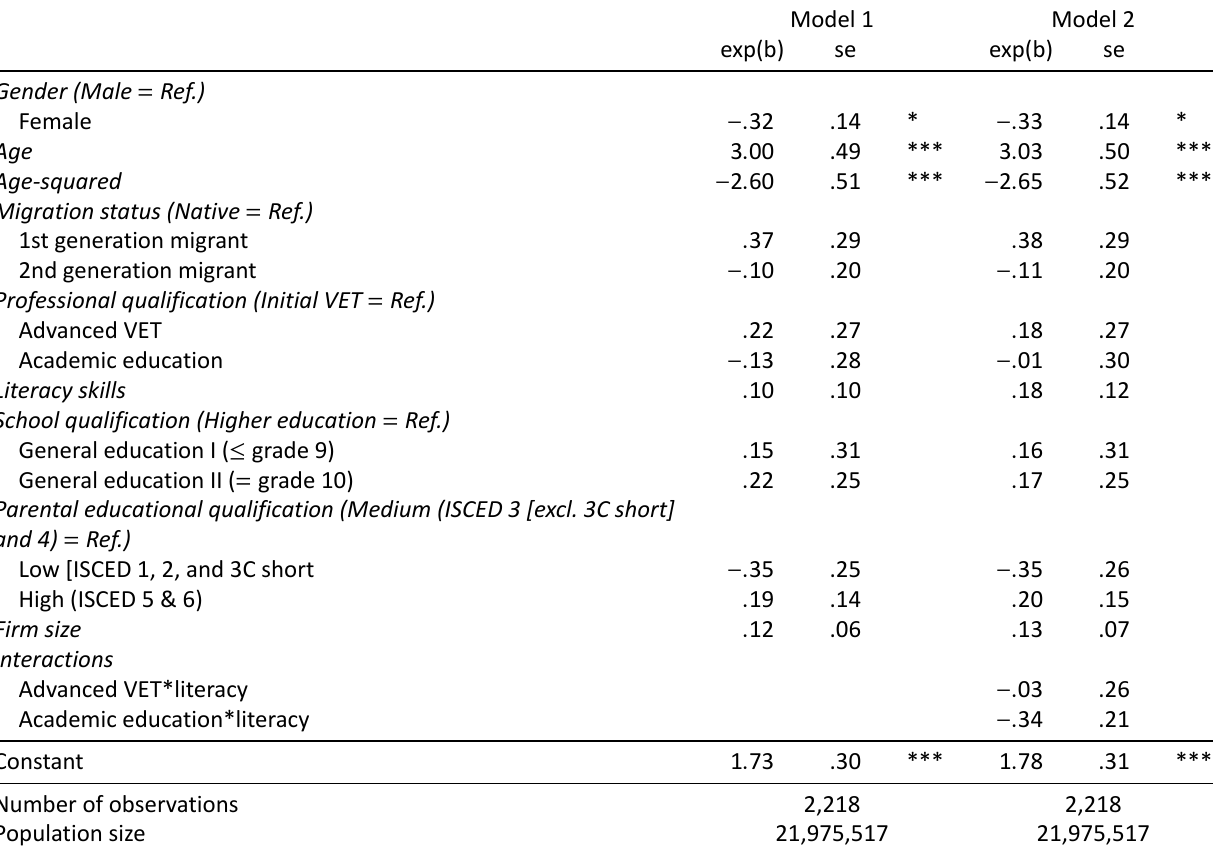
Table A3. Full regression results for job security, logit